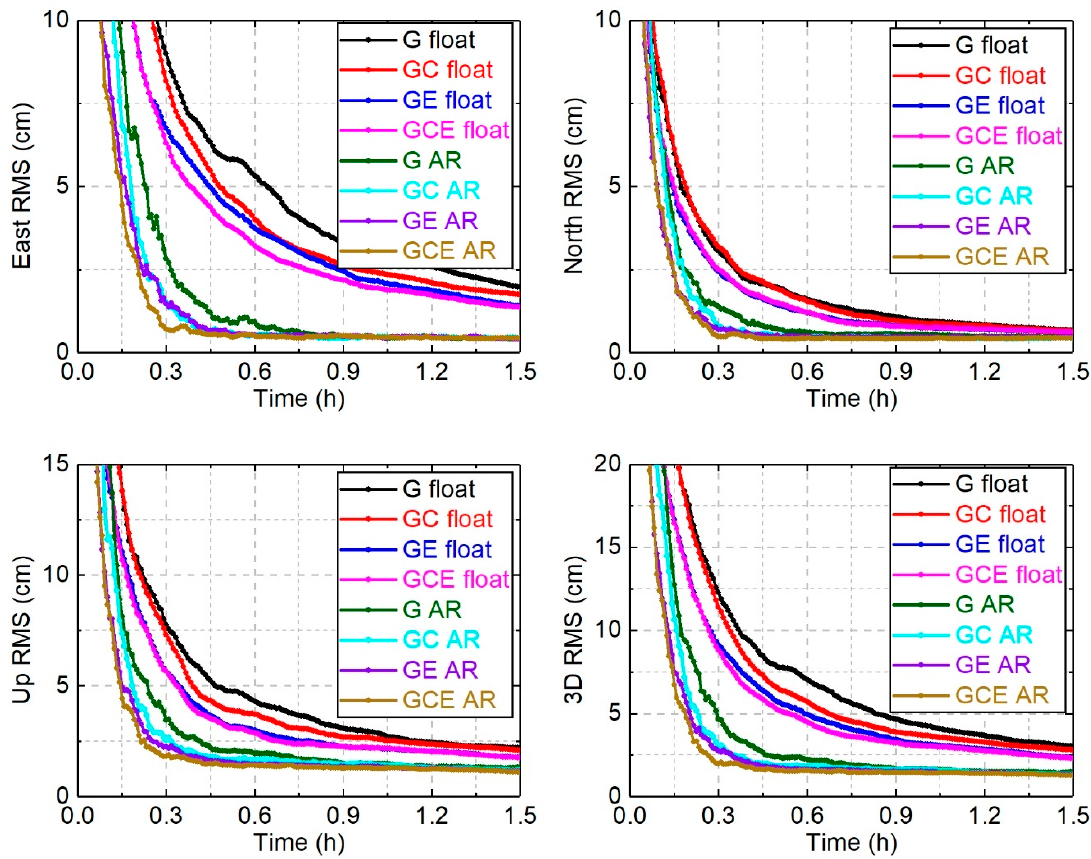
Figure 17. Convergence of the positioning bias for “G”, “GC”, “GE”. and “GCE” systems in the ambiguity-float and ambiguity-fixed solutions with 1.5 hour data. Table 2. Positioning accuracy for GPS, BDS-2, and Galileo.